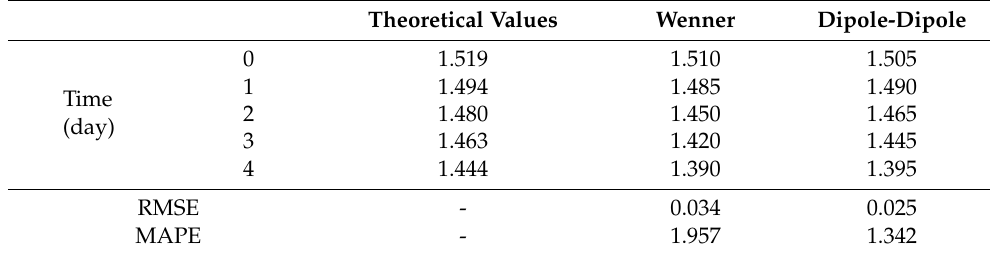
Table 6. The FOS obtained by the proposed framework under the combination of multiple conditions. Theoretical